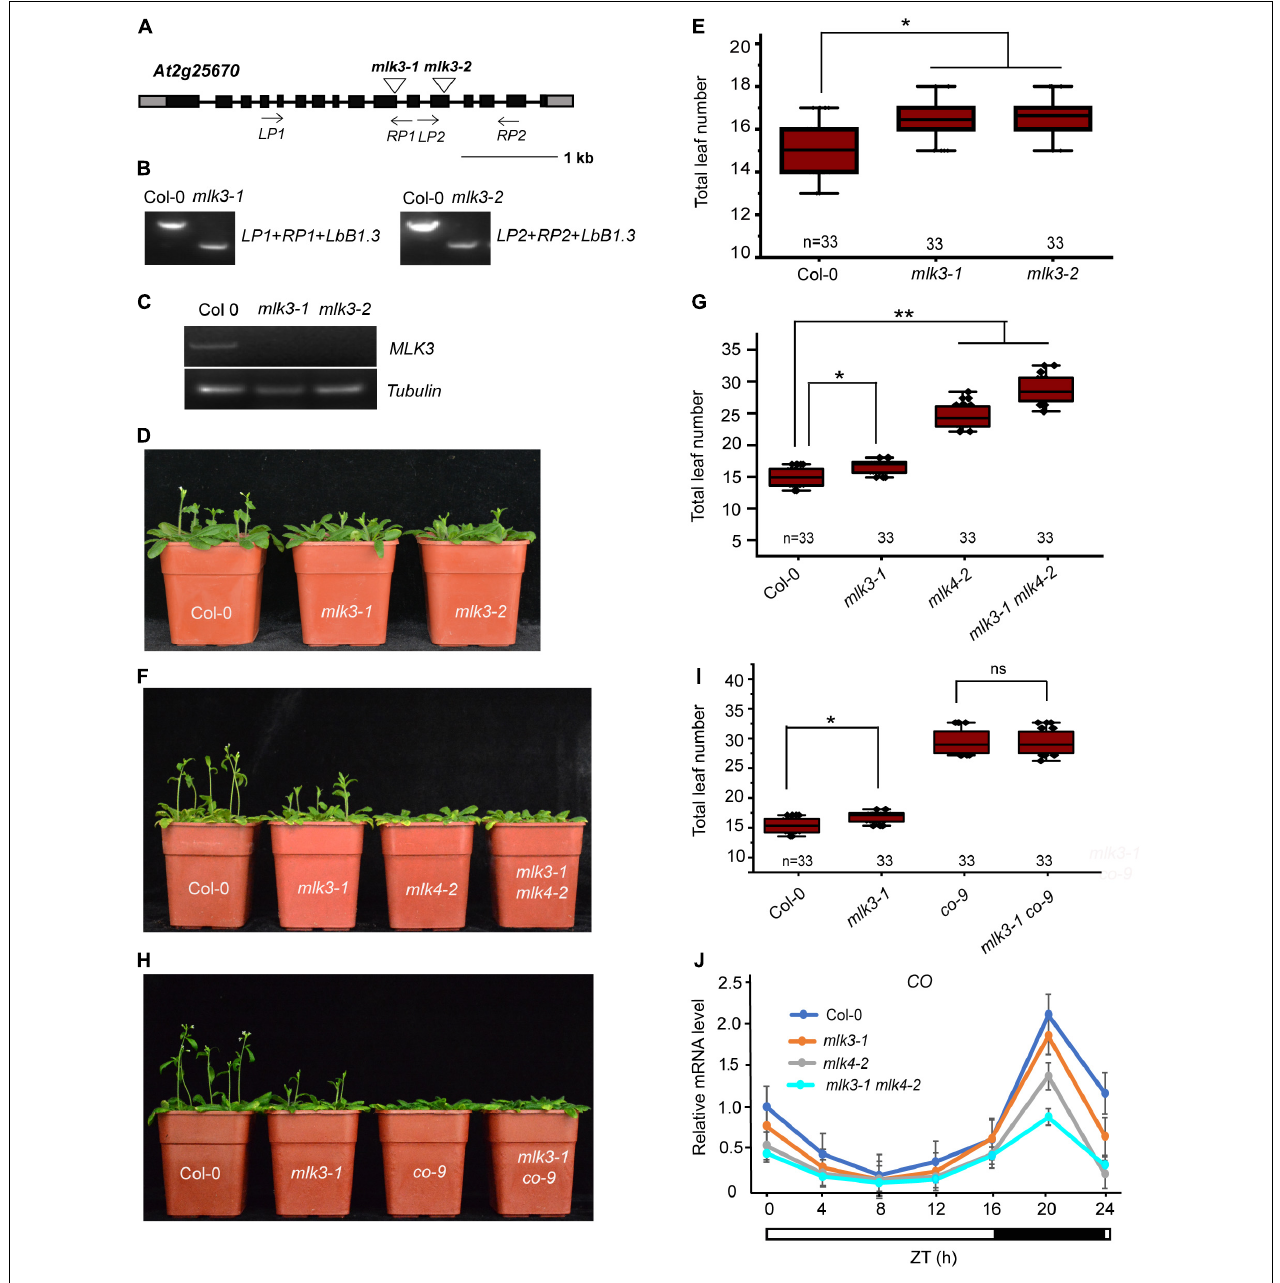
FIGURE 1 | MLK3 is involved in photoperiod flowering time pathway. (A) Gene structure of MLK3 , indicating exons (boxes), introns (lines), and T-DNA insertions (triangles). The primers used for genotype analysis are marked with arrows. (B) Genotypic analysis of the mlk3 mutants. The genotype was analyzed with the left genomic primer (LP), right genomic primer (RP), and the vector primer (LBb1.3). The positions of LP1, RP1, LP2, and RP2 are indicated in panel (A) . (C) The full-length MLK3 transcript in the mlk3 mutants was examined by RT-PCR. (D) The representative phenotype of Col-0 and mlk3 mutants under a LD photoperiod. (E) The total leaf number of Col-0 and mlk3 mutants under a LD photoperiod. Flowering time was assessed by counting the number of rosette leaves and cauline leaves at bolting under LD. Values shown are mean ± SD of total leaves; 33 plants were scored for each line. Asterisks indicate P < 0.05 by t -test, ns indicates no significance. (F) The representative phenotype of Col-0, mlk3-1 , mlk4-2 , and mlk3-1 mlk4-2 plants under a LD photoperiod. (G) The total leaf number of Col-0, mlk3-1 , mlk4-2 , and mlk3-1 mlk4-2 mutants under a LD photoperiod. Values shown are mean ± SD of total leaves; 33 plants were scored for each line. Asterisks indicate P < 0.05 by t -test, ns indicates no significance. (H) The representative phenotype of Col-0, mlk3-1 , co-9 , and mlk3-1 co-9 plants under a LD photoperiod. (I) The total leaf number of Col-0, mlk3-1 , co-9 , and mlk3-1 co-9 mutants under a LD photoperiod. Values shown are mean ± SD of total leaves; 33 plants were scored for each line. Asterisks indicate P < 0.05 and ns indicates no significance by t -test. (J) The transcript levels of CO were examined in Col-0, mlk3-1 , mlk4-2 , and mlk3-1 mlk4-2 mutants. The white bar indicates the light periods, and the black bar indicates the dark period. ZT, Zeitgeber time. Experiments were repeated at least three times, and the representative experiments shown indicate the mean ± SE, n = 3